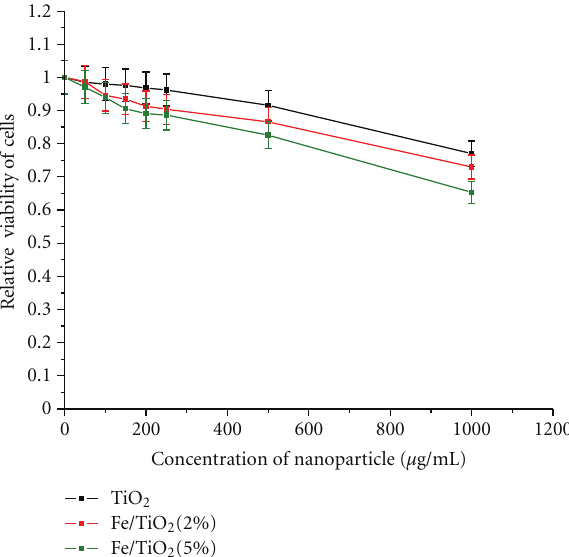
Figure 7: The influence of nanomaterial concentration on the relative viability of HL60 cells. Data are presented as the means ± S.D. from five independent measurements. ∗ P values are less than 0.05 as compard with untreated control